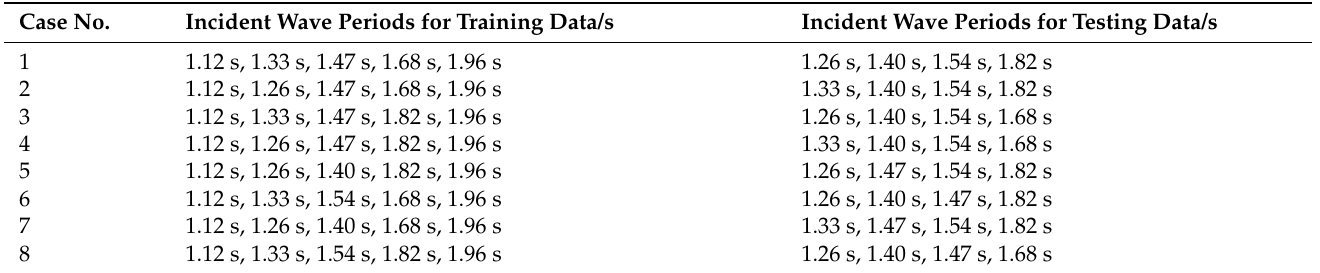
Table 5. Arrangement of training and testing data (5 training data points).